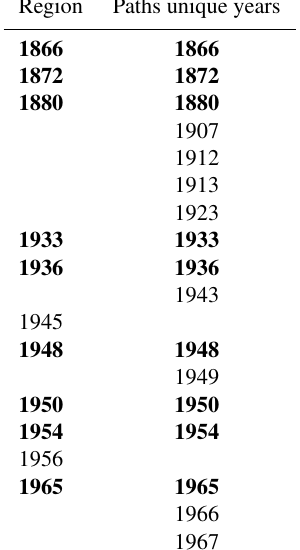
Table A5. Avalanche years identified in the regional analysis (Region; n = 29) and avalanche years identified in one or more paths in the individual avalanche path analysis (Paths unique years; n = 49). Years in bold indicate years in common between the two sets ( n =